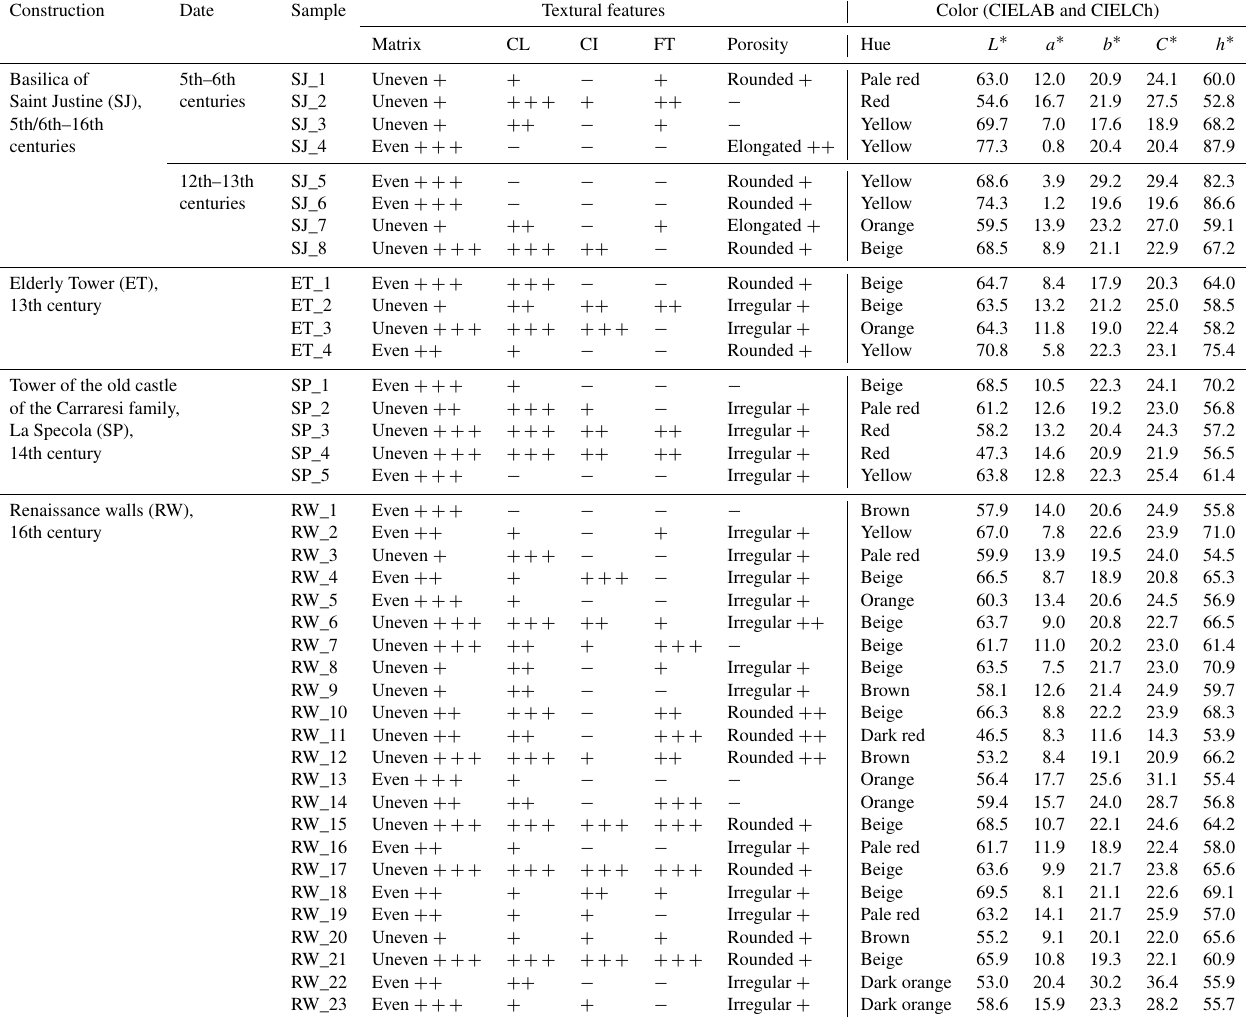
Table 1. List of the samples taken, their main textural features and colorimetric parameters measured on a freshly cut surface. Abbreviations: CL, clay lumps; CI, carbonate inclusions; FT, flowing texture; + , slightly; ++ , quite; +++ , very; − , not